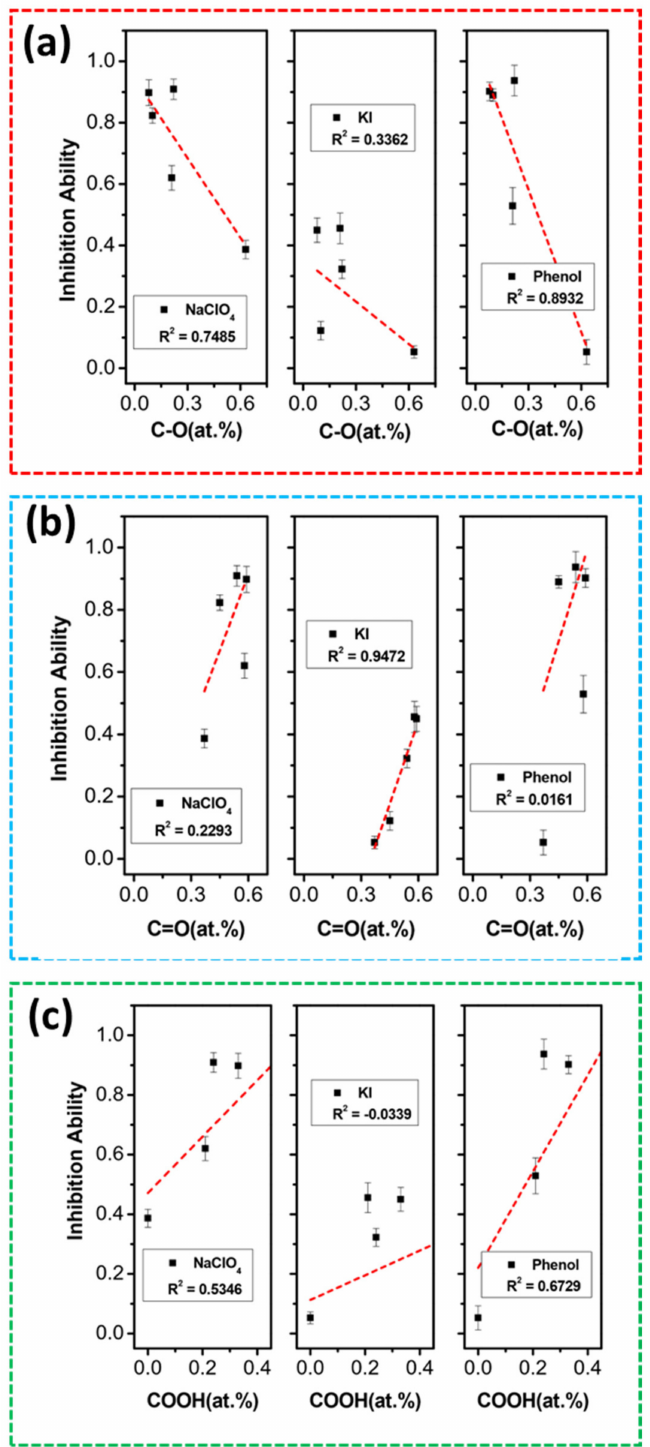
Figure 10. Role of non-radical (free electrons, surface-bound radicals ( • OH and SO 4 • − ) and surface- bound activated complex) quenchers on ACP degradation rate ( k 1 ). Correlation between k 1 -C-O ( a ), k 1 and -C=O ( b ) and k 1 and -COOH ( c ). Quenching studies were carried out at C ACP = 10 mg L − 1 , C Catalyst = 100 mg L − 1 , C PMS = 0.5 mM, C FFA = C L-His = 50